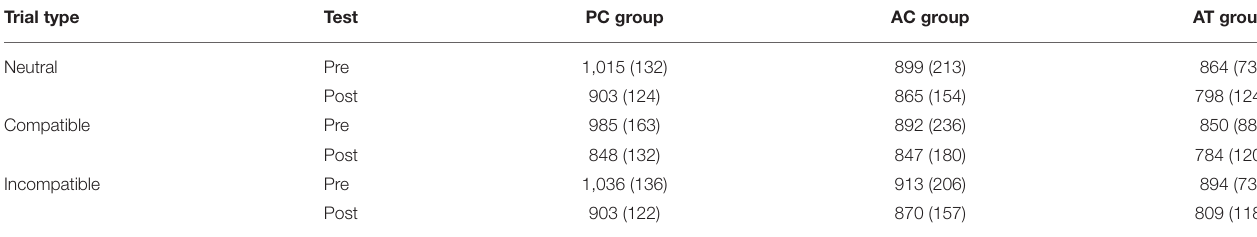
TABLE 3 | Mean RTs (ms) in the Number Stroop task on neutral (letters), compatible (digits corresponding to the number of items) and incompatible trials (digits not corresponding to the number of items) in old